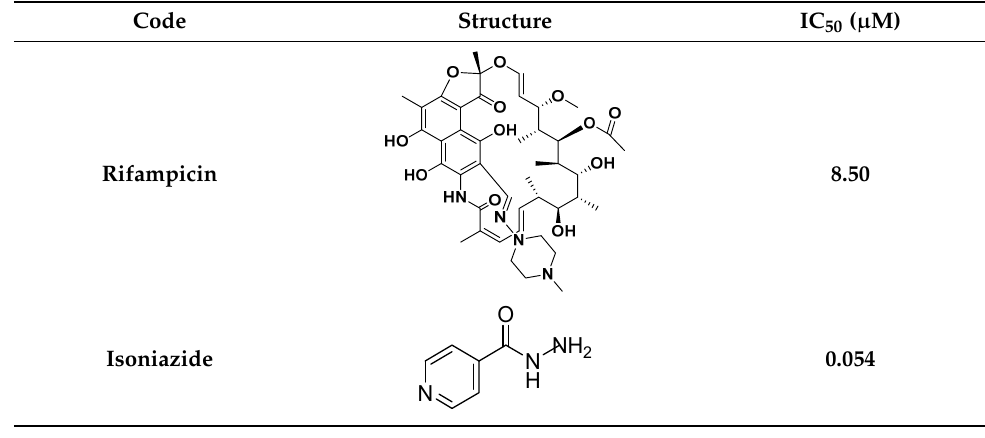
Table 1. InhA inhibition (IC 50 ) of 9-14 with respect to rifampicin.